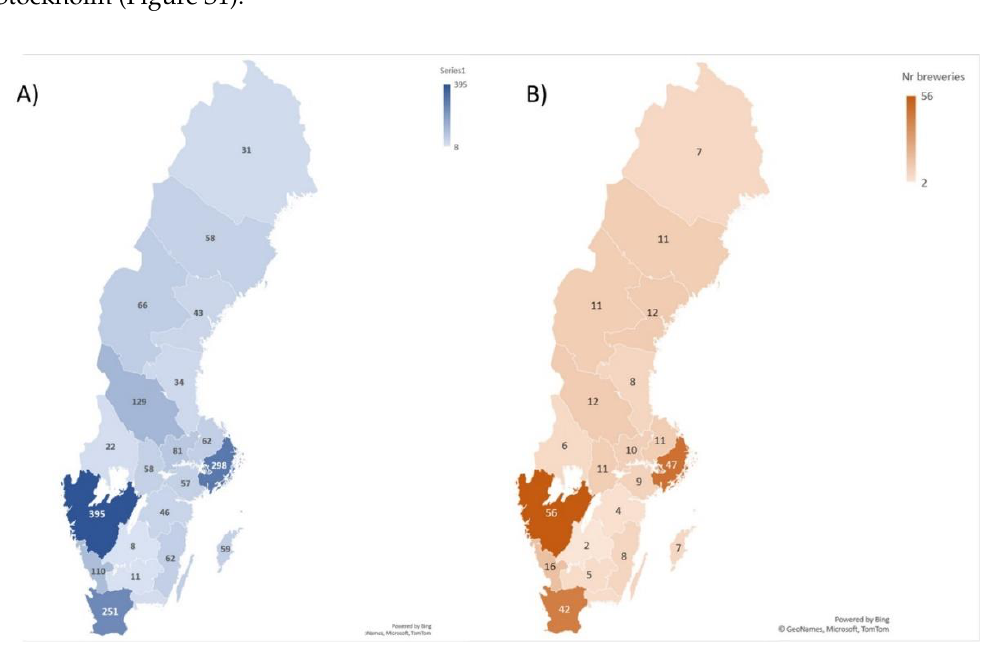
Figure 2. ( A ) Demographic distribution of Swedish beers available at Systembolaget in March 2020. ( B ) Distribution of breweries in Sweden.